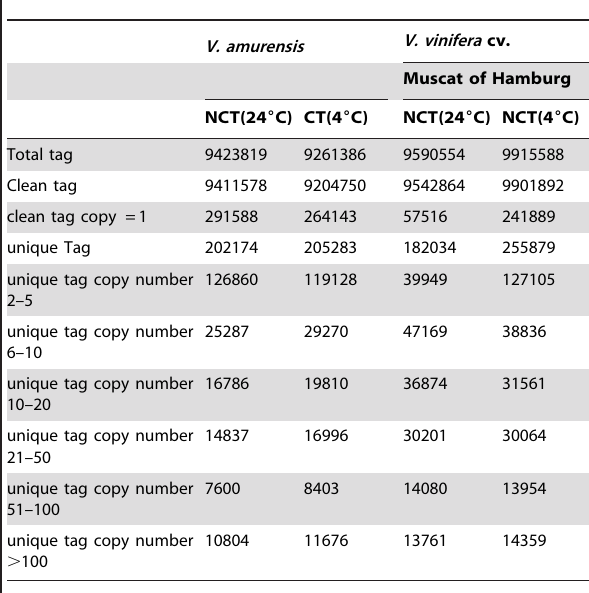
For V. vinifera cv. Muscat of Hamburg, 9,590,554 and 9,915,588 tags were generated from NCT and CT libraries respectively Table 1. Tags in non-cold treatment (NCT) and cold treatment (CT) libraries in V. amurensis and V. vinifera cv. Muscat of